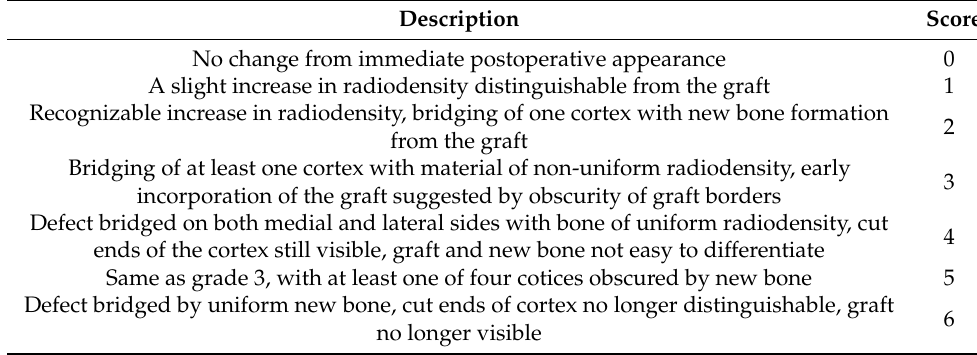
Table 1. Radiographic grading scale for degree of healing (Cook et al.). Description